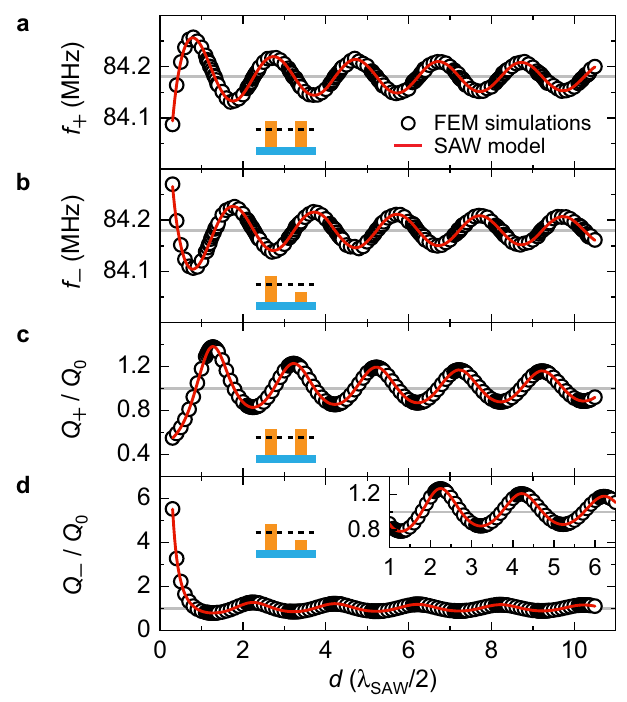
Fig. 3 Finite element method simulations of a pair of pillar resonators. a , b Eigenfrequencies and ( c ), ( d ) quality factors of the symmetric and antisymmetric modes as a function of the distance d between the pillars. The grey lines mark the properties f 0 = 84.18 MHz and Q 0 = 208 of a single pillar resonator. The red lines are plots of Eqs. (8) and (9) for g = 0.027 and exploiting ω ± ≈ ω 0 . The insets illustrate schematically the mode of vibration of the pillars. The black dashed lines represent the height of the pillars for no